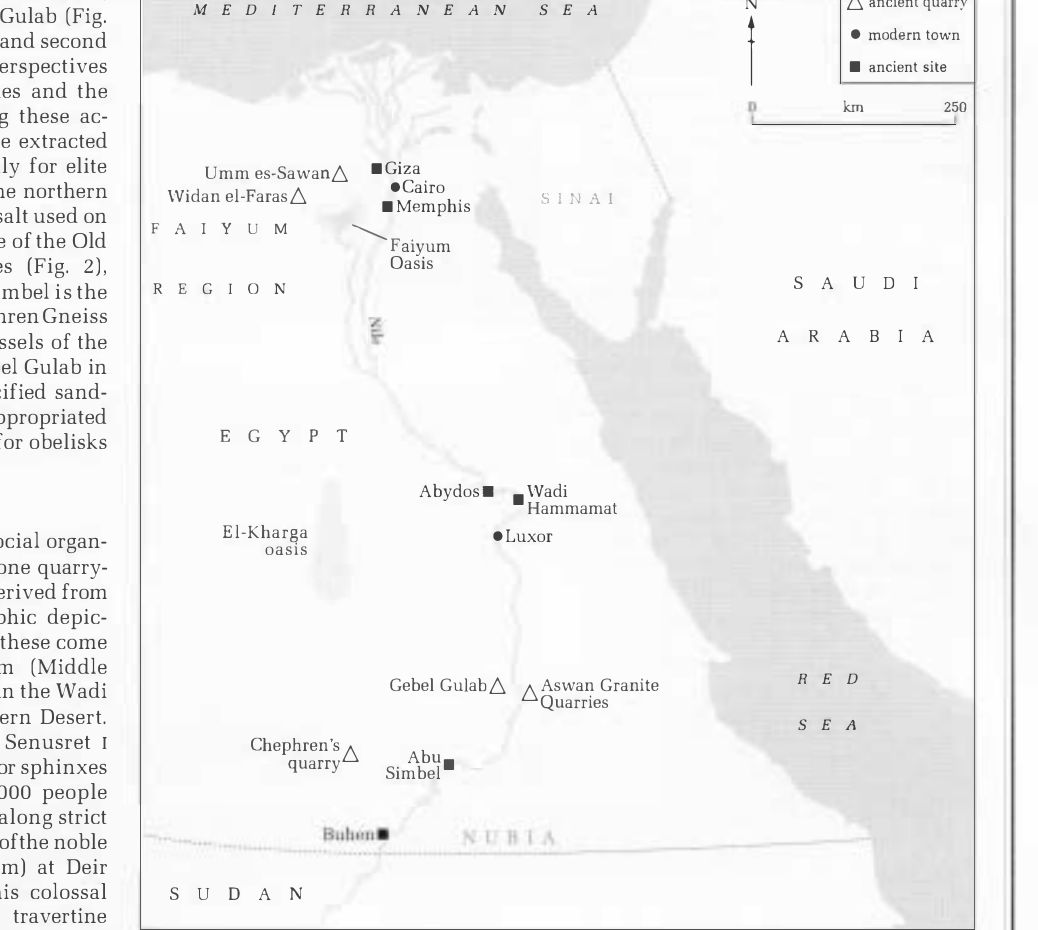
Figure 1 Egypt, showing ancient quarries mentioned in the